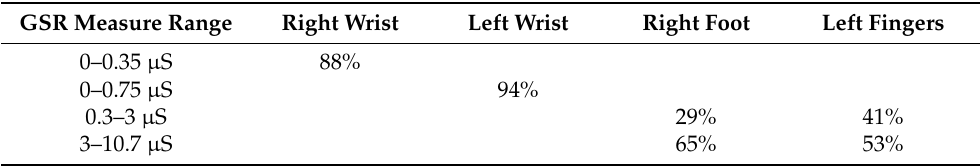
Figure 7. Illustration of the differences in the GSR measurement range observed in the experiment: a case of differences between two types of sensors ( a ); a case of differences in different types of sensors ( b ). Table 5. GSR measurement range of each measurement location.